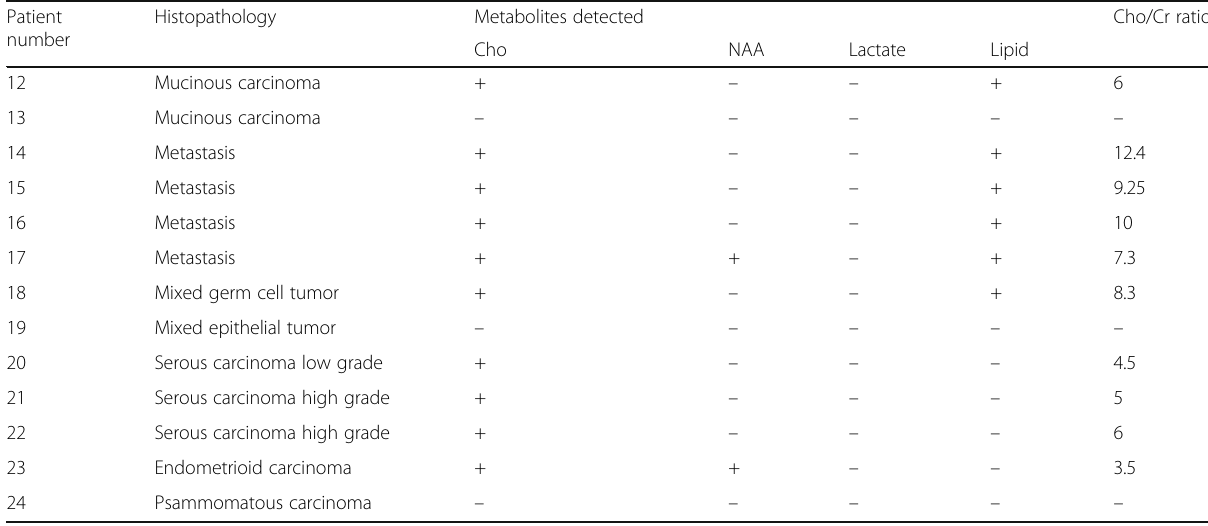
Table 3 Metabolite levels in 13 malignant cases